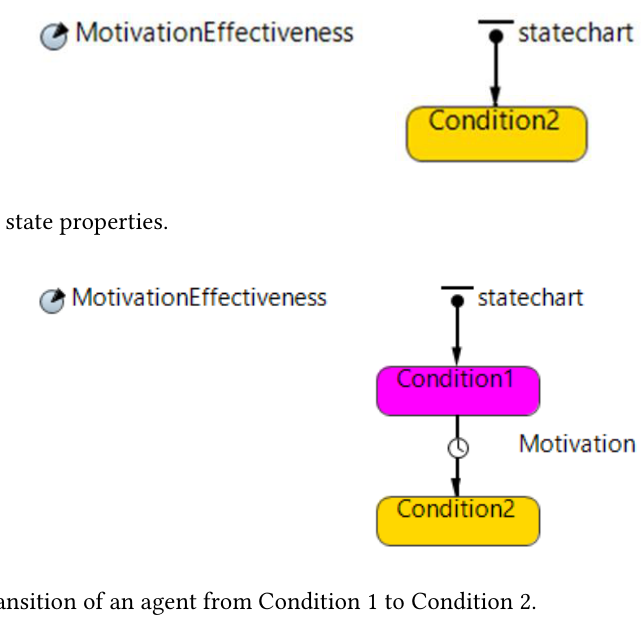
Figure 5: Adding the first state of the agent to the work area.